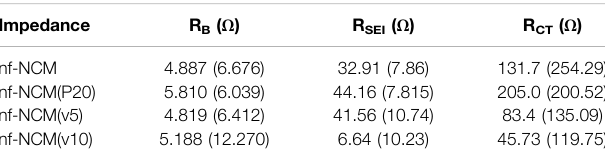
TABLE 1 | Impedance value extracted from electrochemical impedance spectra before and after stability cycling. The impedance value for post-formation is written in the bracket.